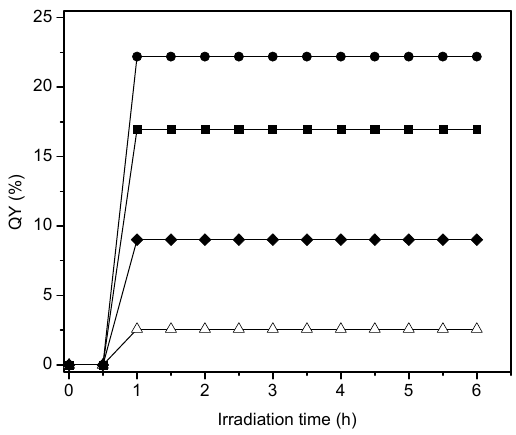
Figure 18. Quantum yields at various irradiation times for: ( ● ) 2.50 wt. % Pt–TiO 2 (sol-gel B), ( ■ ) 1.70 wt. % Pt–TiO 2 (sol-gel A), ( ♦ ) 1.70 wt. % Pt–TiO 2 (wetness impregnation) and ( ∆ ) Degussa P25. Note: TiO 2 (Degussa P25) is reported as a